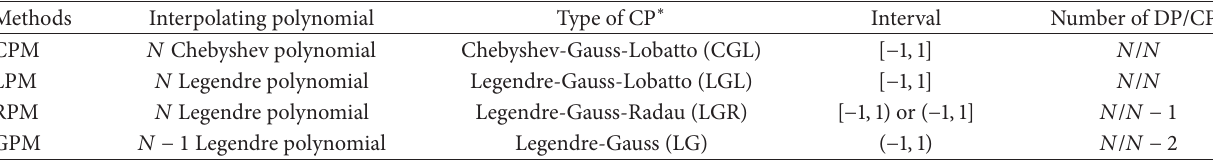
Table 1: The key features of some well-known pseudospectral